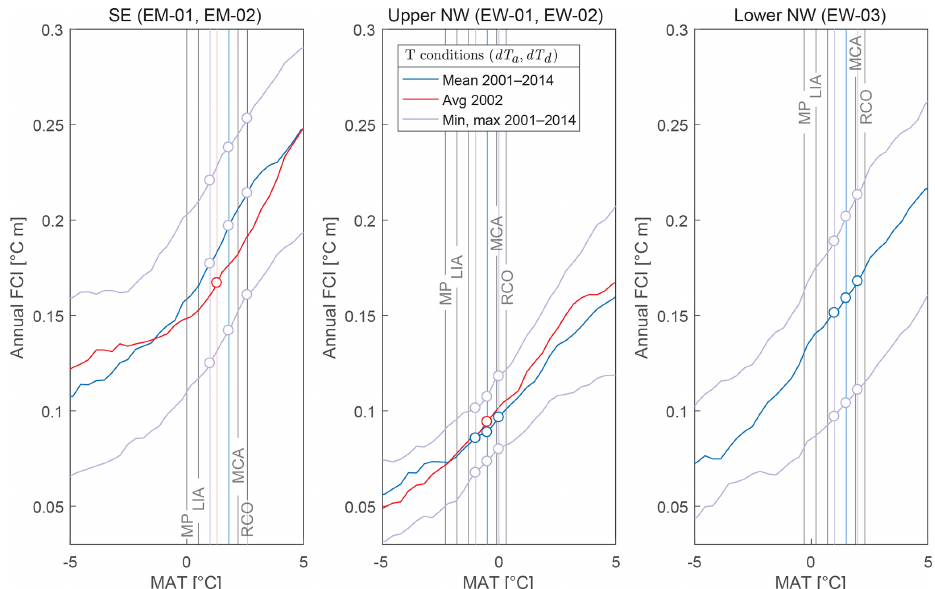
Figure 6. Modeled annual frost cracking intensity (FCI) for the individual sites and the different thermal regimes. For the site-specific model run conditions (min, max, mean and 2002) see Table 1 and Sect. 3.2. Resulting FCI values for the indicated circles are presented in Table 4. MAT: mean annual temperature; LIA: Little Ice Age; MCA: Medieval Climate Optimum; MP: Migration Period; RCO: Roman Climatic